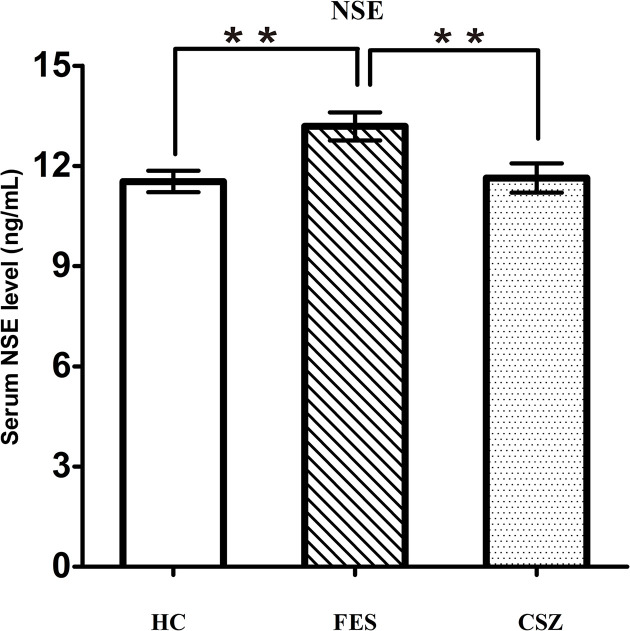
Representative of serum level of NSE. ** means P < 0.01. Error bars denote mean and SD. FES, first-episode schizophrenia; CSZ, chronic schizophrenia; HC, healthy controls; NSE, neuron-specific enolase.